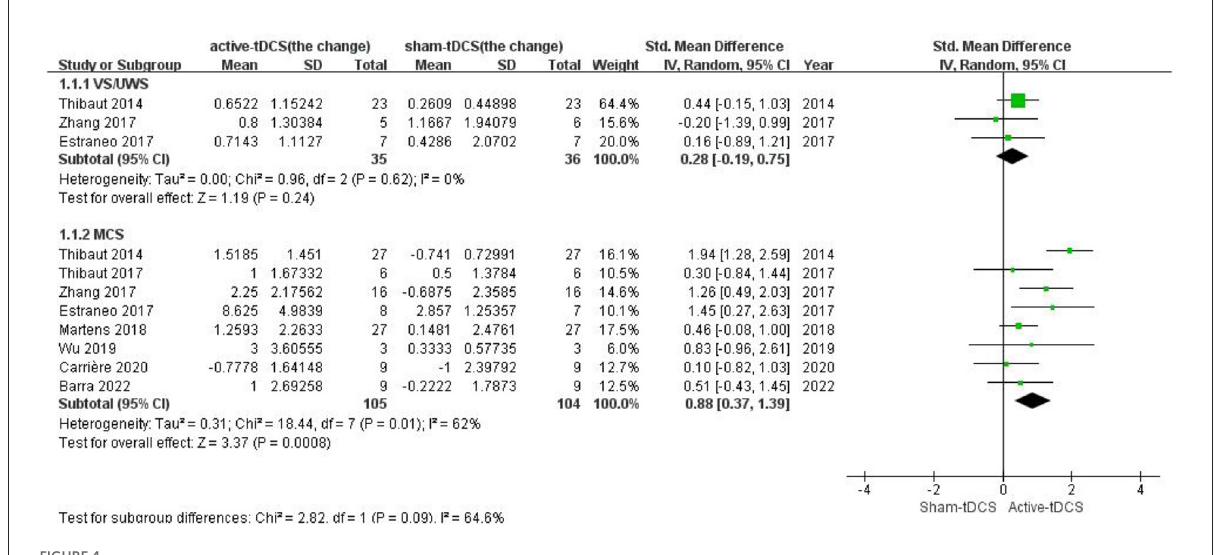
FIGURE4 Subgroup analysis of different PDOC